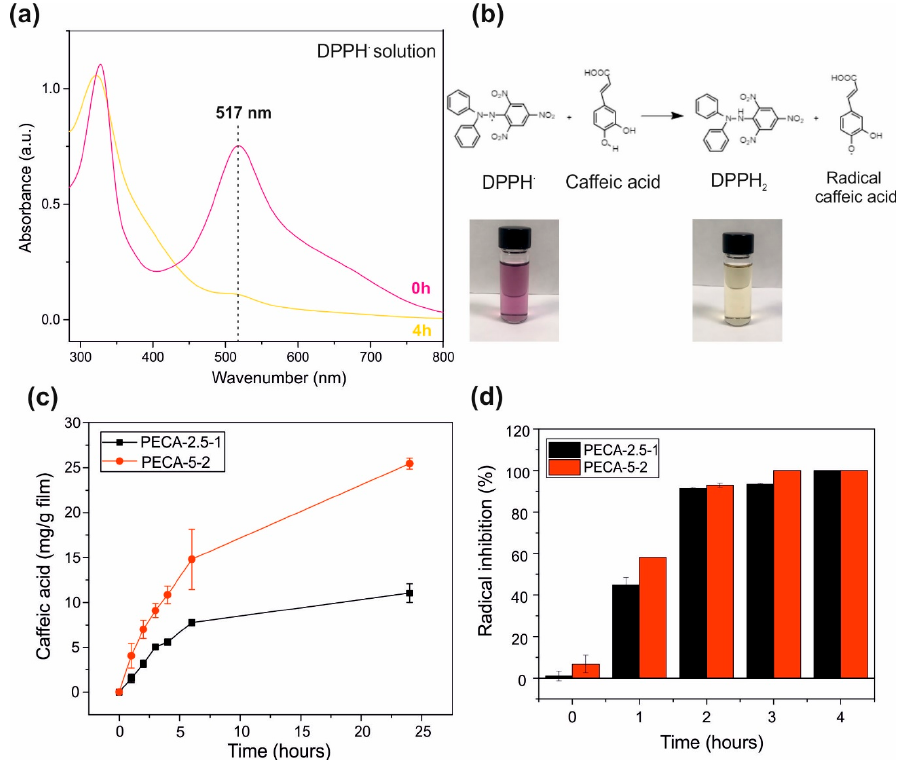
Figure 8 . ( a ) The UV-Vis spectra of the radical solution ( DPPH ∙ ), at time point zero (in violet) and after 4 h (in yellow). ( b ) The mechanism of the scavenging reaction between the caffeic acid and ( DPPH ∙ ). The color change of the solution after scavenging reaction, from strong violet to yellow, is also represented. ( c ) Transient caffeic acid release profiles for PECA-2.5-1 and PECA-5-2 in (mg/g film). ( d ) Percent radical inhibition values of PECA-2.5-1 and PECA-5-2 films over a 4-h period. All results are represented as mean ± SD of three measurements.